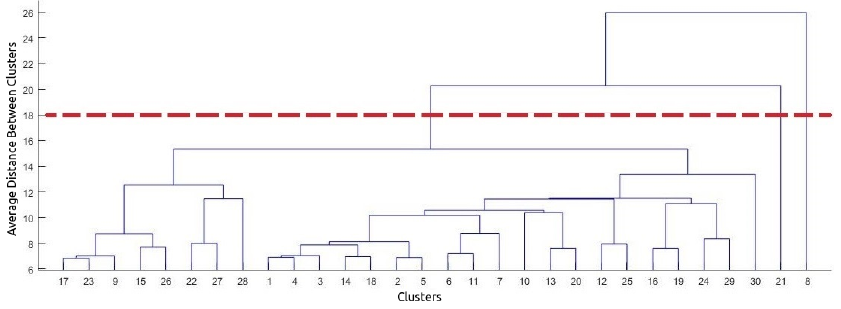
Figure 2. Dendrogram for light